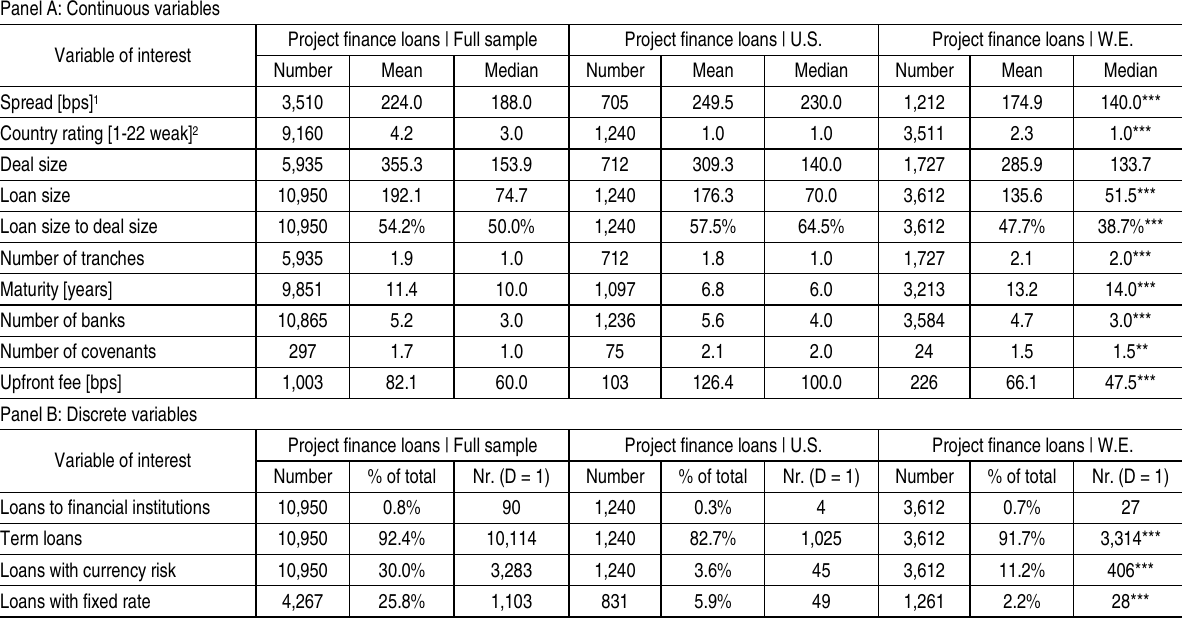
Table 4. Contractual characteristics of the sample of PF